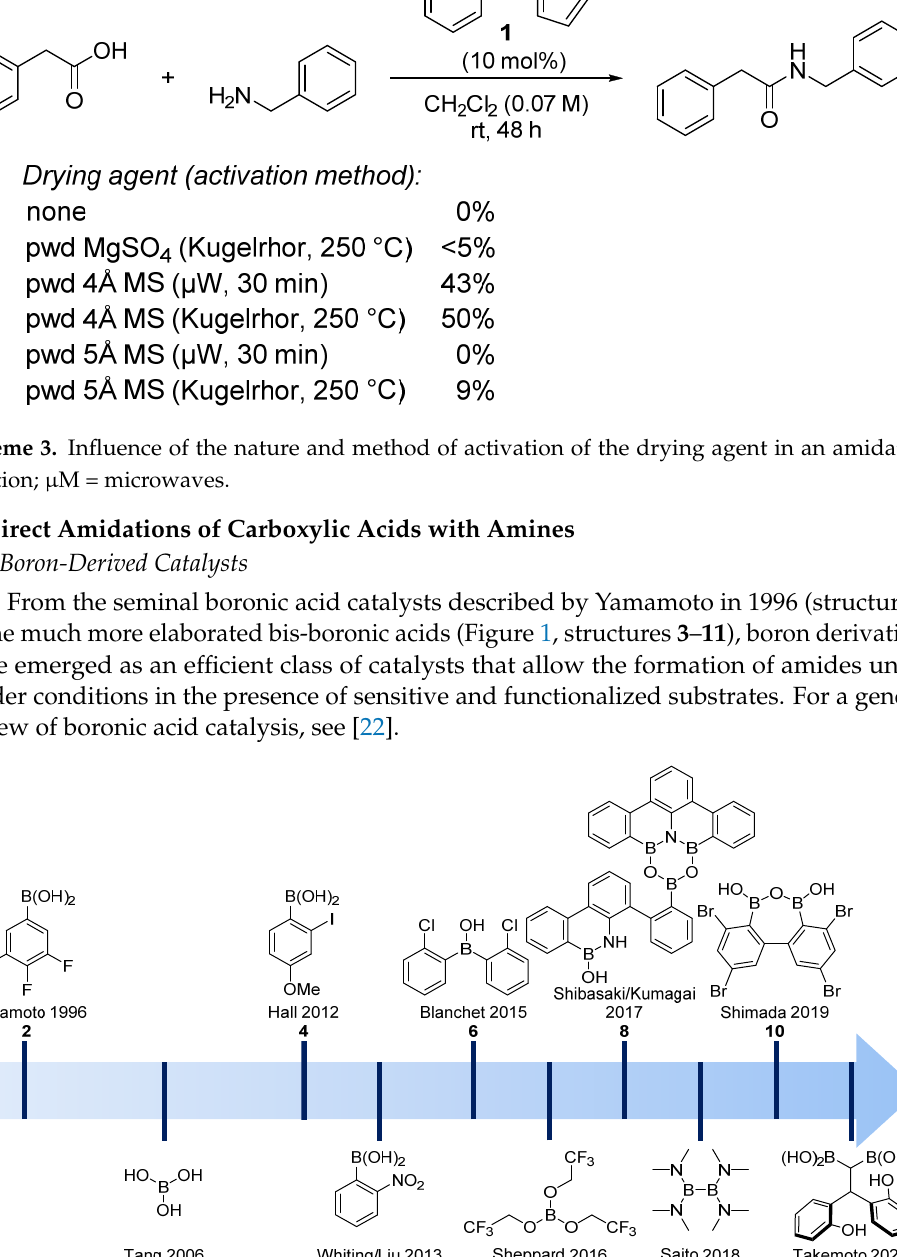
Figure 1. Evolution of boron ‐ derived catalysts used in direct amidation reactions.